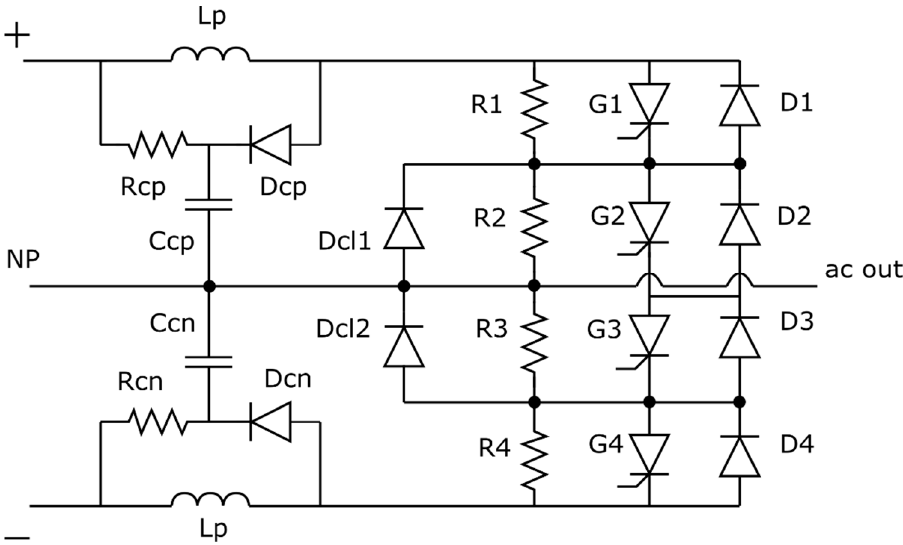
Figure 3. Electrical scheme of one inverter module.